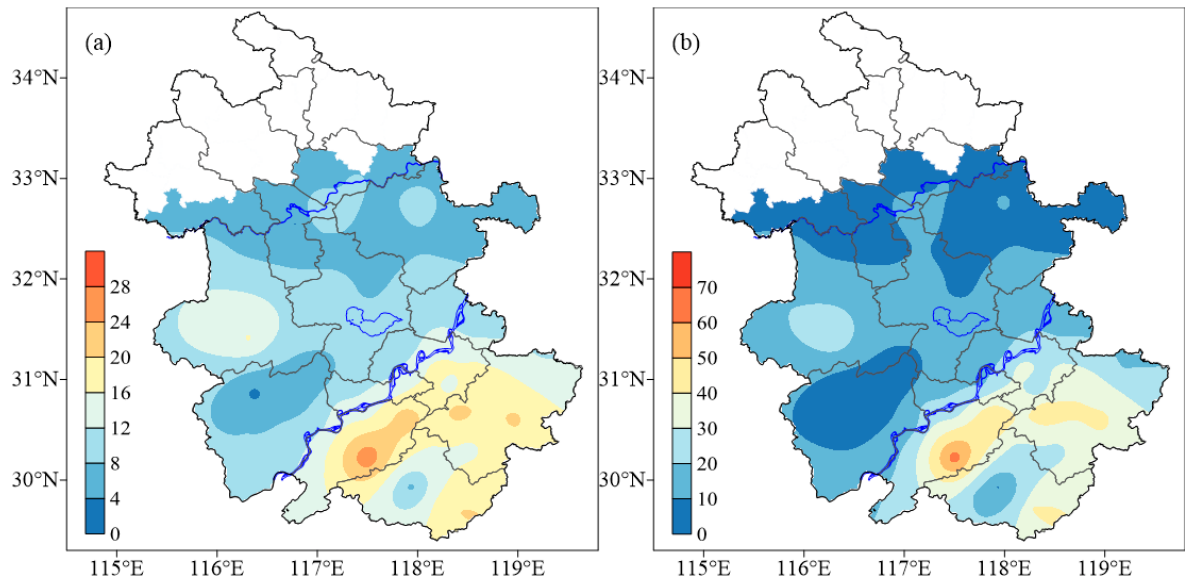
Figure 3. Spatial distribution of HSWI ( a ) and payout ( b ) based on observations in the area south of the Huai River in Anhui Province from 1961 to 2018.